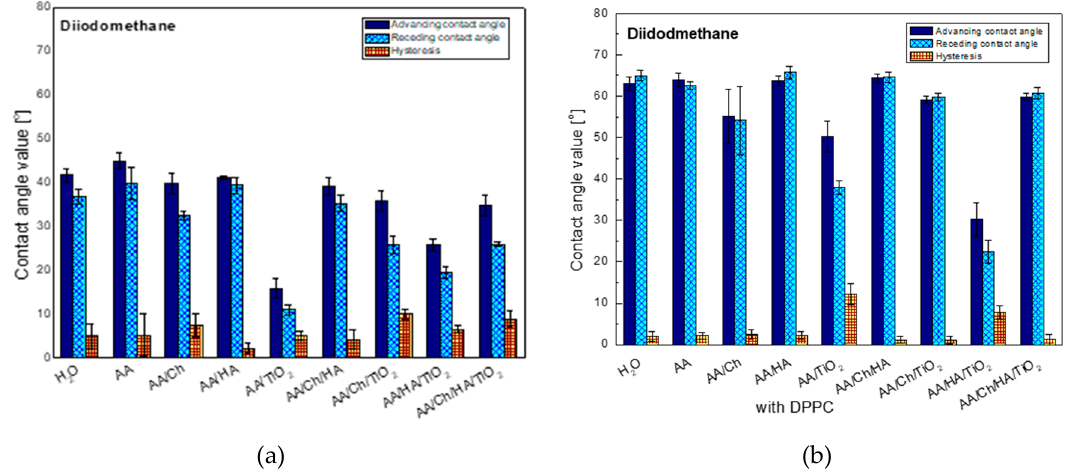
Figure 1. Advancing and receding contact angles of diiodomethane (DM) and its hysteresis on the activated glass plates after contact with the subphase in the absence of DPPC ( a ) and in the presence of DPPC ( b ).